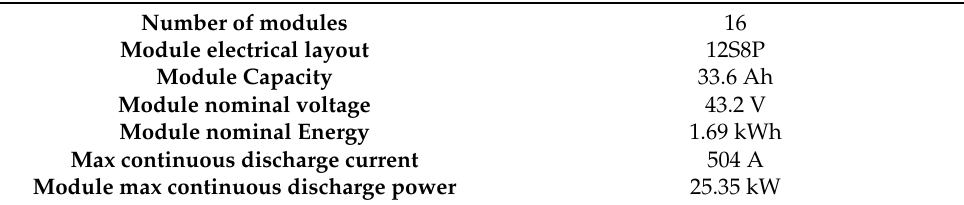
Table 5. Battery pack